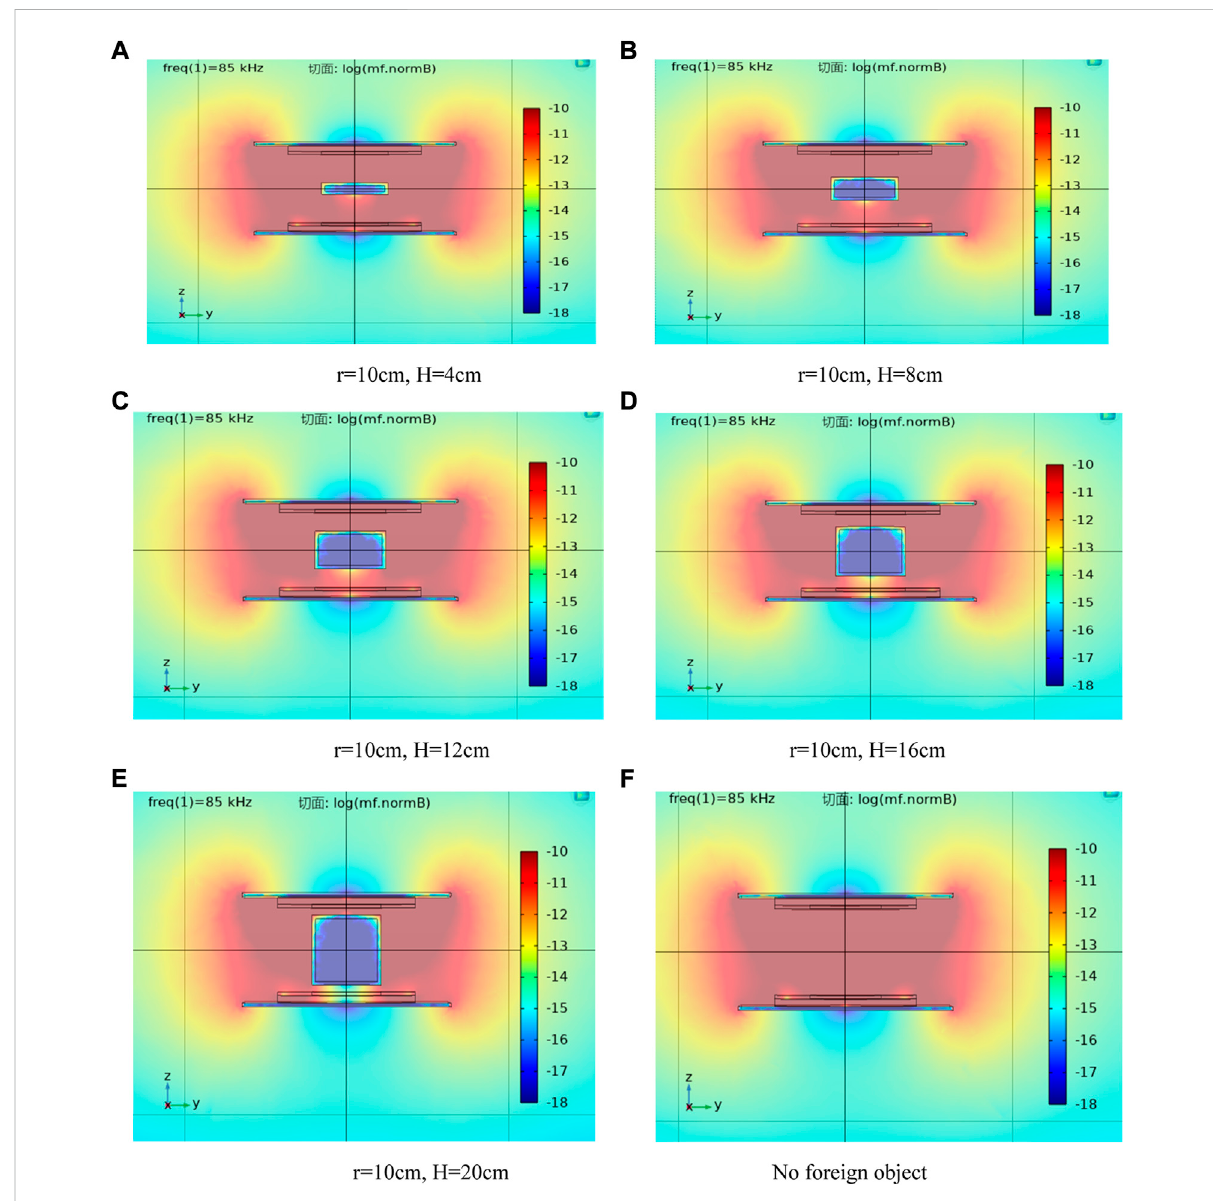
FIGURE 3 Magnetic fl ux density of the coupler when the height of the foreign object changes. (A) r = 10 cm and H = 4 cm. (B) r = 10 cm and H = 8 cm. (C) r = 10 cm and H = 12 cm. (D) r = 10 cm and H = 16 cm. (E) r = 10 cm and H = 20 cm. (F) No foreign